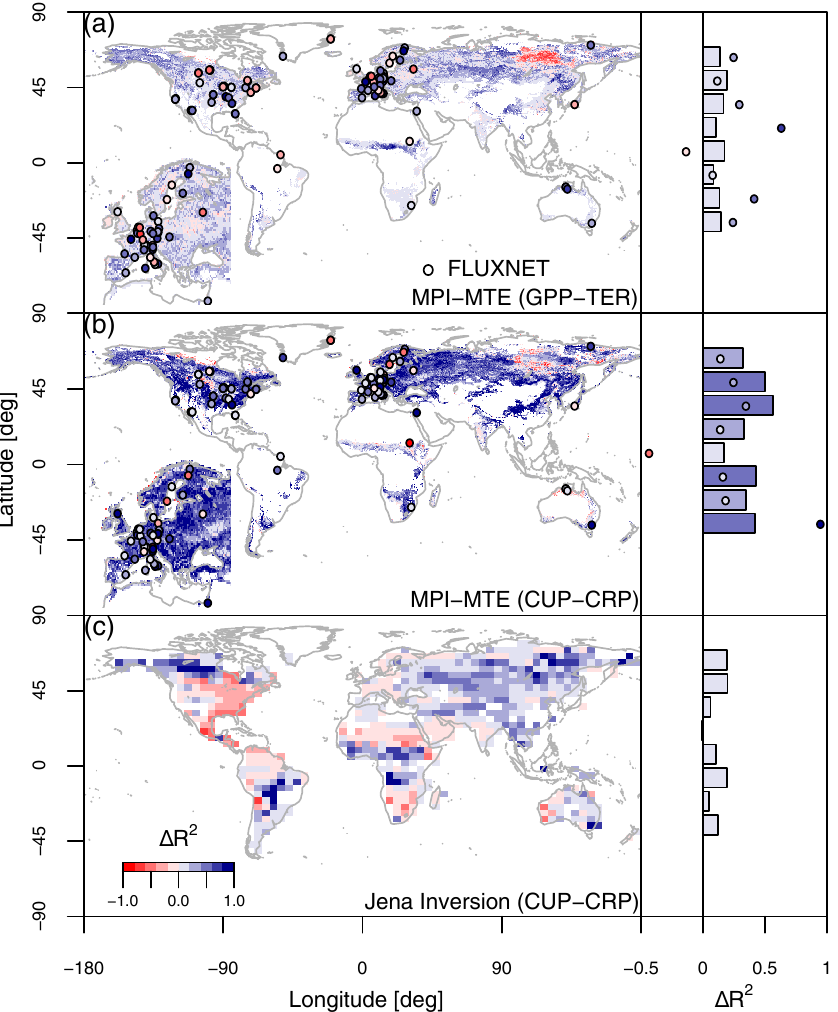
− R 2 for MPI- TER GPP